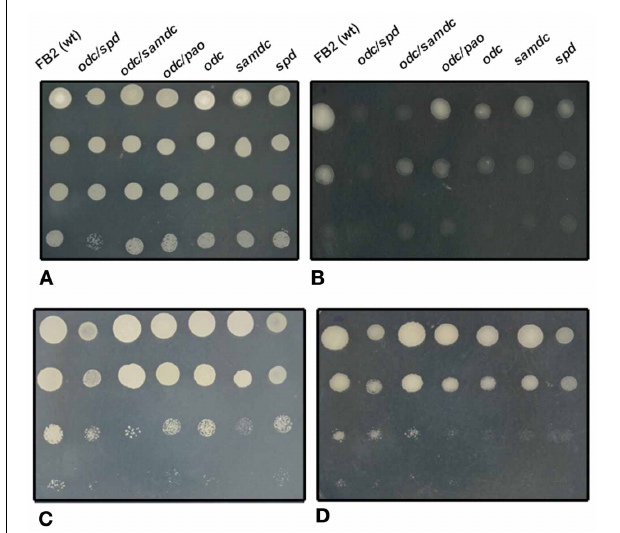
FIGURE 2 | Comparative analysis of different stress conditions on the growth of wild type, and simple and double mutants of U. maydis affected in different steps of polyamine metabolism. After depletion of polyamine pools, cell suspensions were decimally diluted and inoculated on solid minimal medium containing 20mM lysine and 0.1mM spermidine. After 48h of incubation at 28 ◦ C (except in C), photographs were taken. (A) , control; (B) , 1.5M KCl added to the medium; (C) , as (A) , but incubated at 37 ◦ C; (D) , 1M NaCl added to the